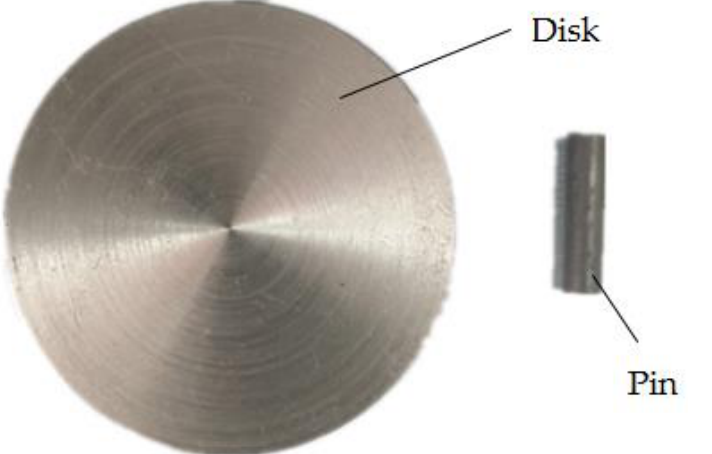
Figure 3. The pin and disk. Table 1. Experimental